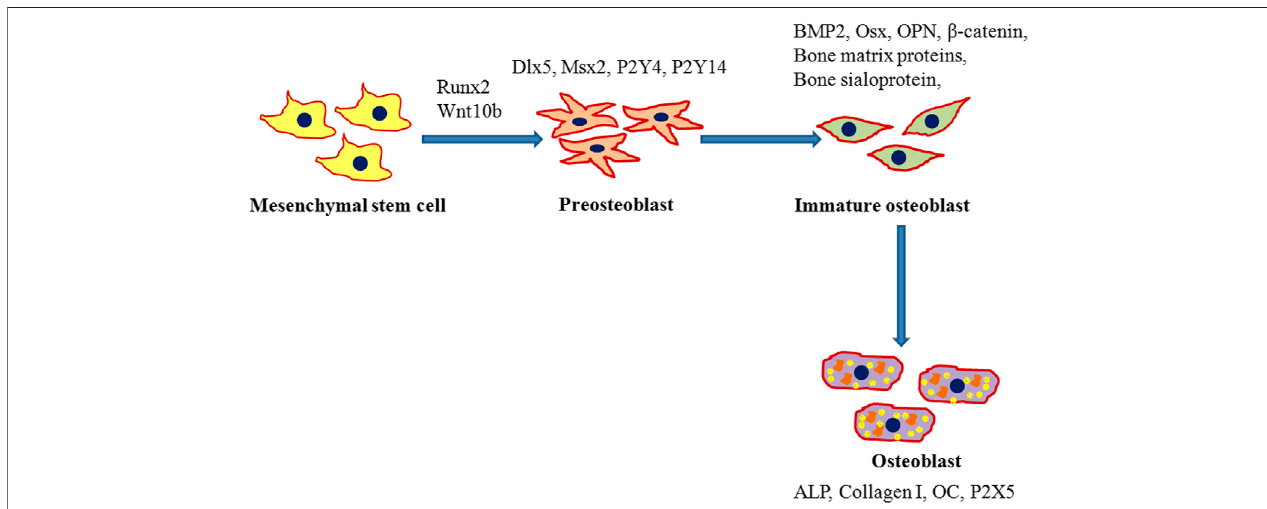
FIGURE 1 | Schematic representation for the differentiation of mesenchymal stem cells (MSCs) into osteoblasts. Runx2 mediated commitment of MSCs to an osteogenic lineage followed by the initial formation of preosteoblasts that express runt-related transcription factor 2 (Runx2), distal-less homeobox 5 (Dlx5), and msh homeobox homologue 2 (Msx2). Preosteoblasts further differentiate into immature osteoblasts which in turn enhance expression of bone morphogenetic protein 2 (BMP2), Osterix (Osx), β -catenin, bone matrix proteins, bone sialoprotein, and osteopontin (OPN) and develop into mature osteoblasts. Mature osteoblasts with a mineralized cellular matrix express osteocalcin (OC), alkaline phosphatase (ALP), and type I collagen (collagen I).